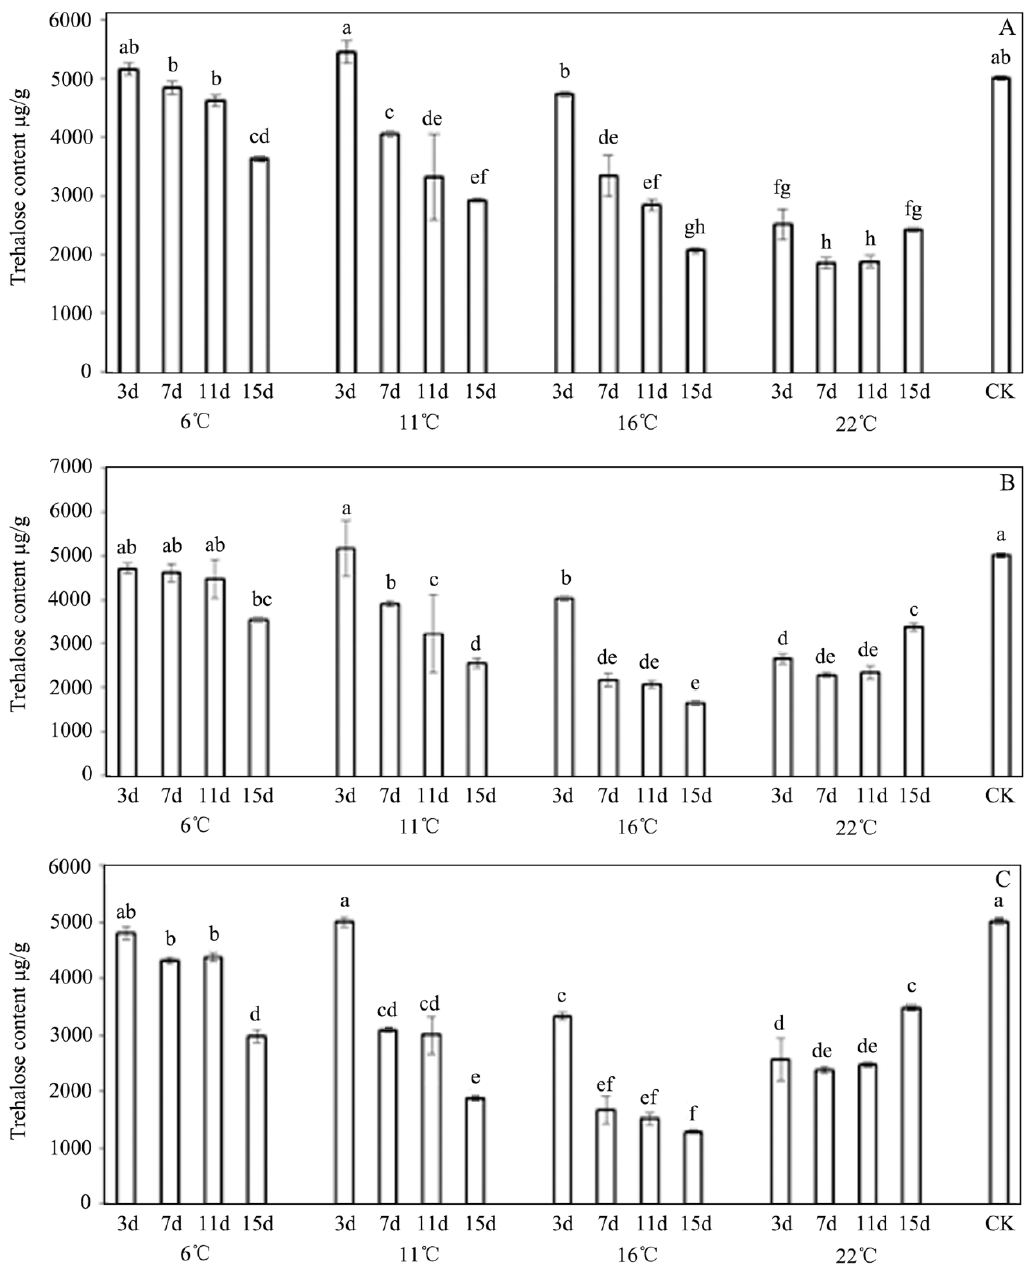
Figure 4. Effect of P. syringae 1.3200 concentration on the trehalose content of E. extimalis . ( A ) 0.1 OD; ( B ) 0.2 OD; ( C ) 0.3 OD. Results are shown as the mean ± SD. Letters on the error bars indicate significant differences analyzed using the one-way analysis of variance (ANOVA) with Tukey’s test ( p < 0.05).